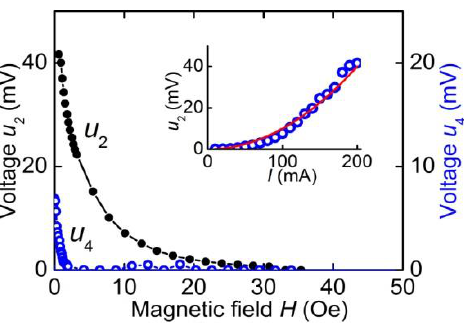
Figure 27. Dependences of ME voltage u on the field H and excitation field h for the Metglas/PZT heterostructure excited by a current flowing through the Metglas layer.